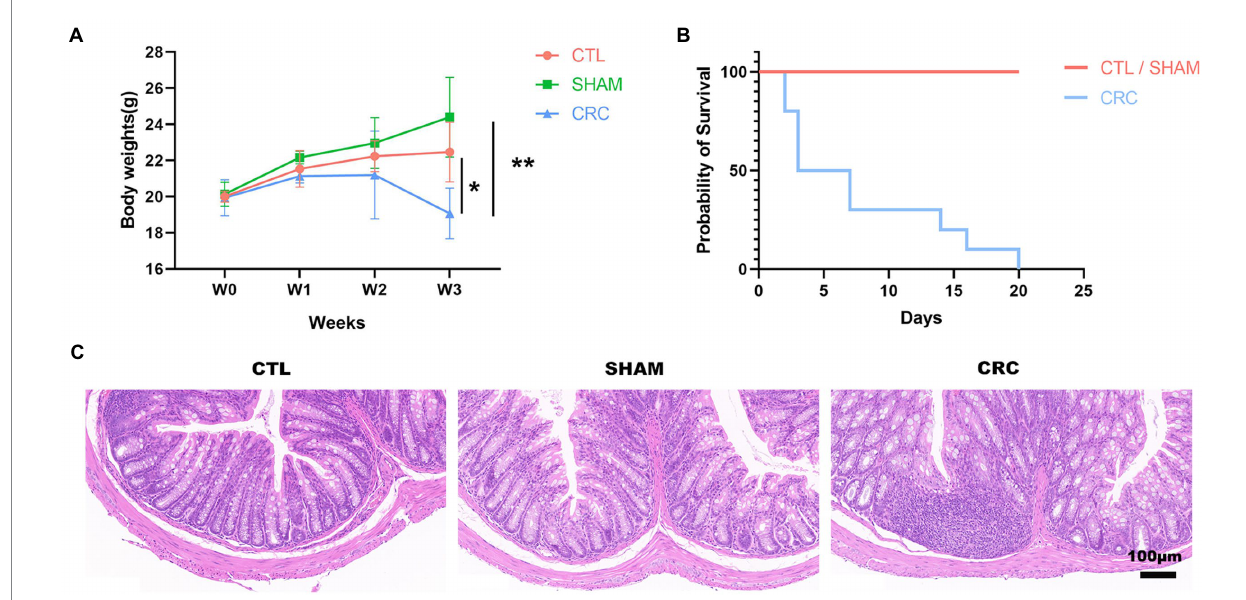
FIGURE 1 Malignant damage to the colonic tissue in the in situ malignant colorectal cancer (CRC) model. (A) Changes in the body weights of mice over 3 weeks. (B) Survival rate. (C) Hematoxylin and eosin (H&E) staining at W3. Scale bar, 100 μ m. Data are mean ± SEM; n ≥ 3, * p < 0.05, ** p <